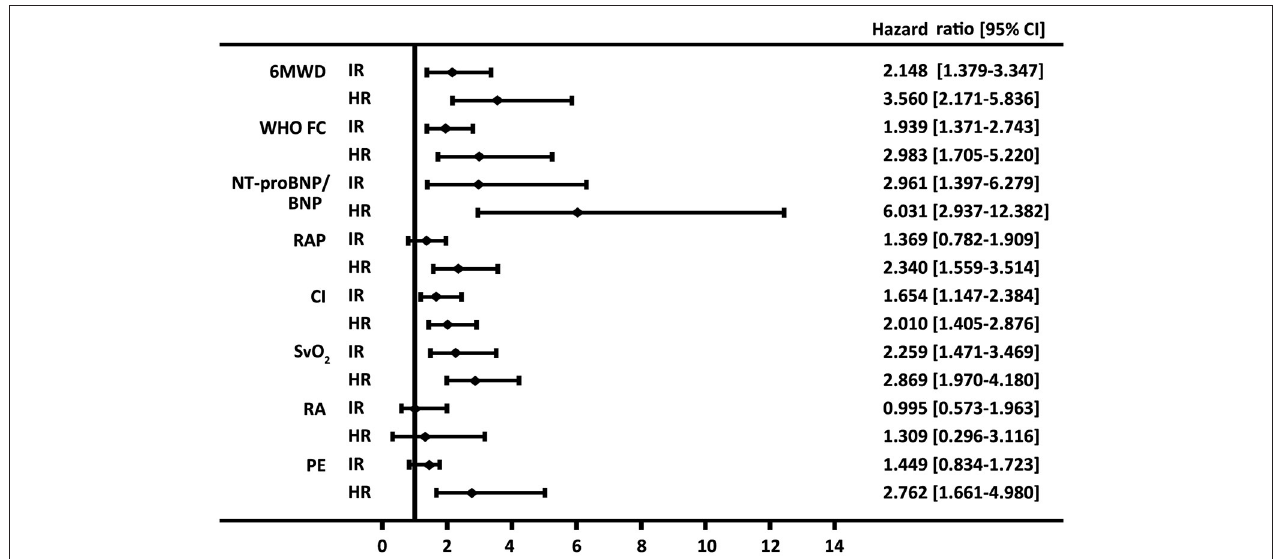
FIGURE 2 | Forest plot based on the prognostic values of 6-min walk distance (6MWD), the WHO function class (FC), brain natriuretic peptide (BNP) or N-terminal proBNP (NT-proBNP), right arterial pressure (RAP), cardiac index (CI) and mixed venous oxygen saturation (S V O 2 ), right atrium (RA) area, and pericardial effusion (PE) in the intermediate-risk (IR) and high-risk (HR) groups. Values for the variables were obtained from baseline. The reference value is from the respective low-risk group.